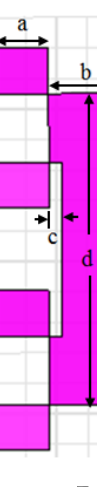
Figure 10. Fractal DGS.